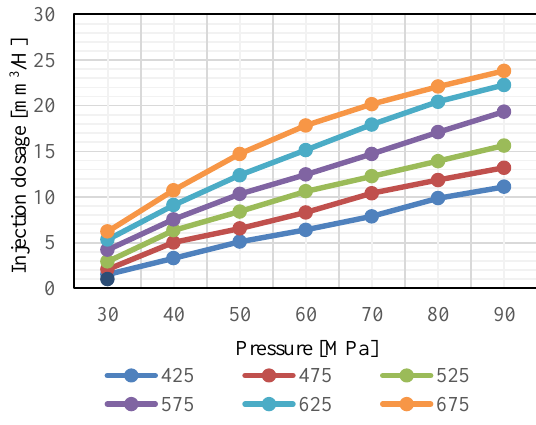
Fig. 4. Operating characteristics of the tested fuel injector – parameters modeled by the neural network